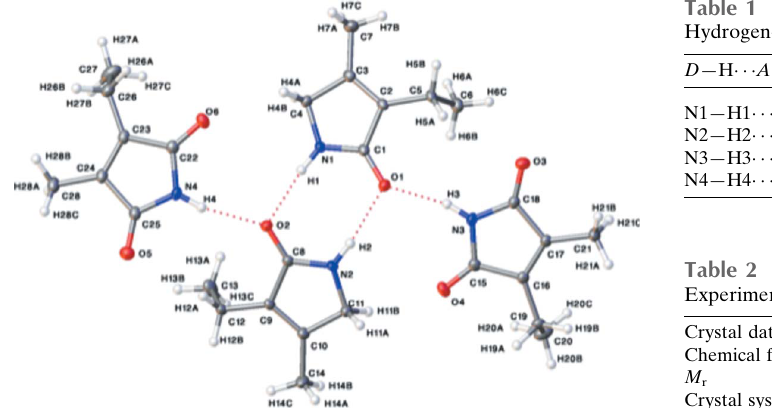
Figure 1 The asymmetric unit of the crystal contains two molecules of each component of the co-crystal, linked together by four hydrogen bonds. Displacement ellipsoids are drawn at the 50% probability